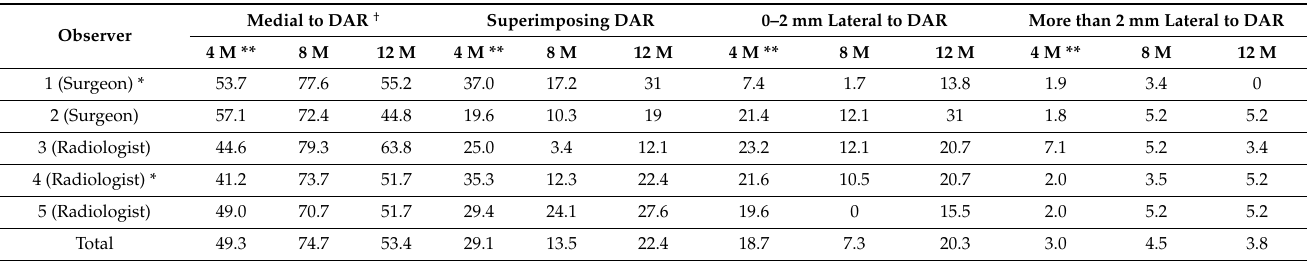
Table 4. Percentages (%) of evaluations of location of center of femoral head (LCFH) by observers at 4 [29], 8, and 12 months of age.